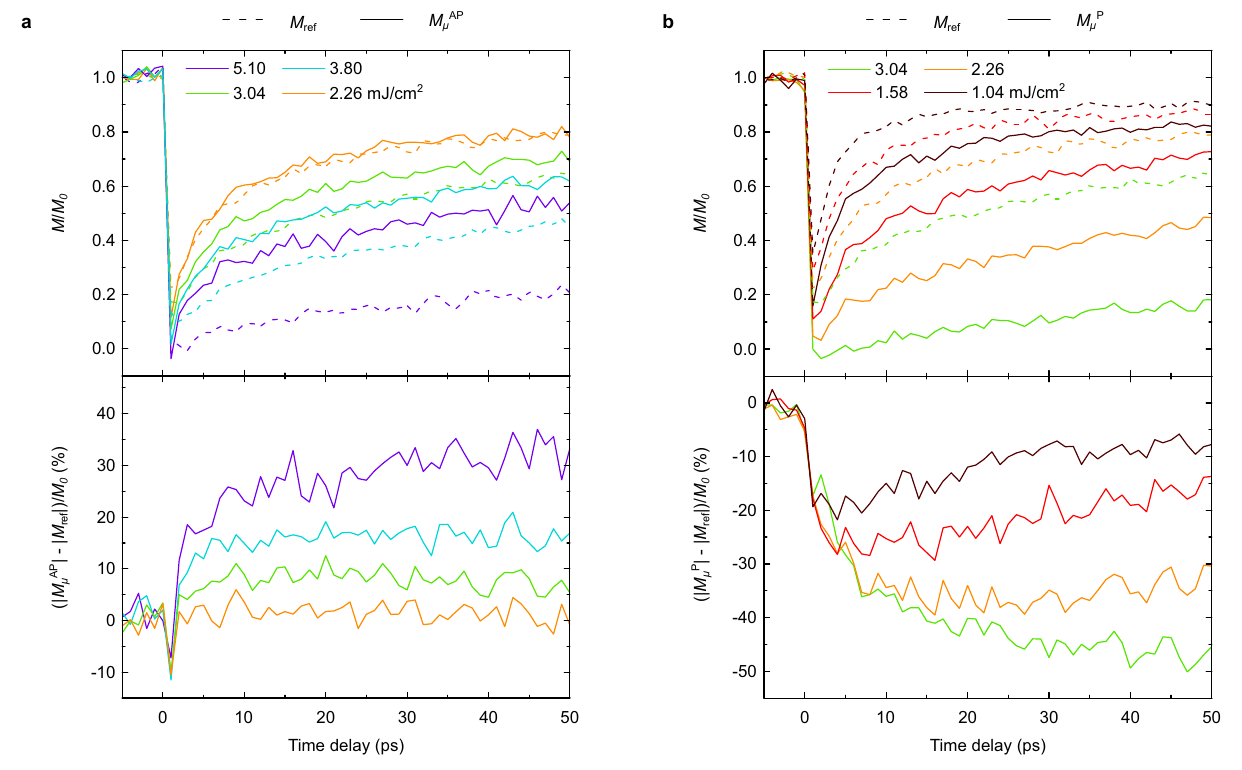
dynamics of the free [Co/Pt] ferromagnetic multilayer in the spin-valve sample in the P con fi guration M P μ (solid line). The bottom panel shows the effect of the spin current generated by the GdFeCo layer on the magnetization dynamics of the free [Co/Pt], i.e., ð ∣ M P μ ∣ (cid:2) ∣ M ref ∣ Þ = M 0 . The color code for the considered fl uences is shown in the top panel in each case. The time delay step has been chosen to be larger and of 1ps. Zero time delay is here chosen to be the longest delay where there is no observable